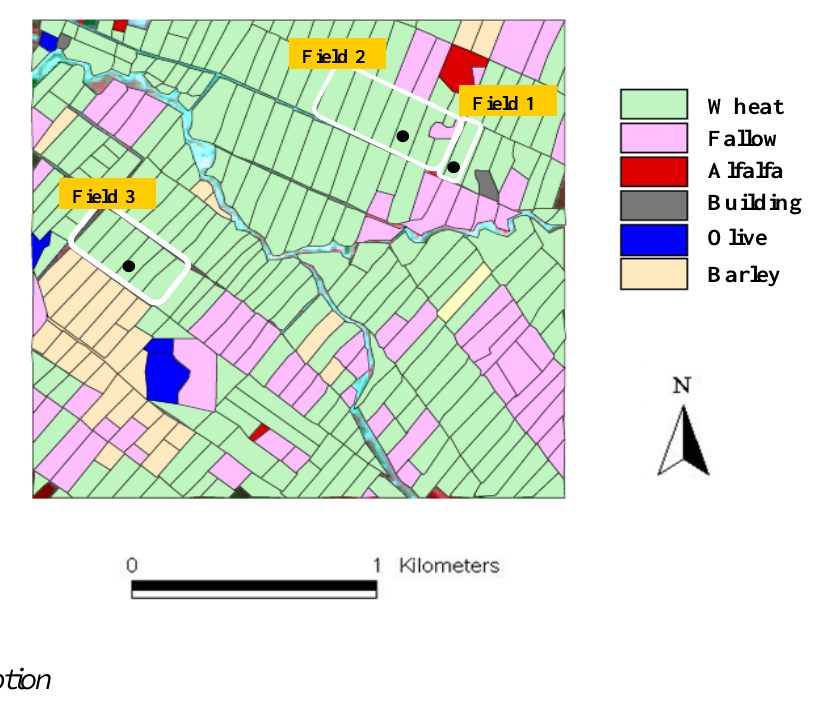
Figure 1. Land cover (coloured shapes) and location of three wheat fields (delimited with white rectangles) under study during 2002–2003 agricultural season in the Tensift AL Haouz, Marrakech, Morocco. The towers equipped with evapotranspiration measurement systems (black disks) are located in each